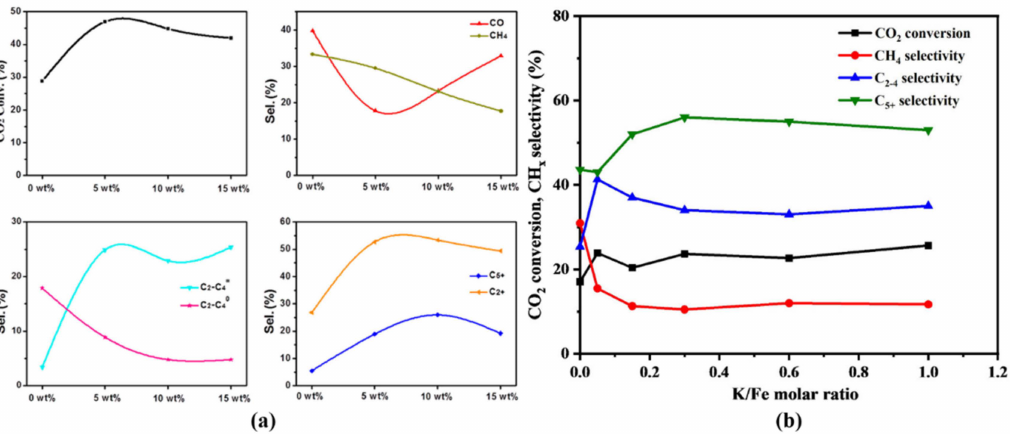
Figure 1. ( a ) Effects of the K content on the catalytic performance over Fe 5 C 2 -( x )K/a-Al 2 O 3 catalysts. Reaction conditions: 400 ◦ C, 3.0 MPa, GHSV = 3600 mL · g cat–1 · h –1 , H 2 /CO 2 = 3. Reprinted with permission from Liu et al. [16]. Copyright (2018) American Chemical Society. ( b ) Effects of the